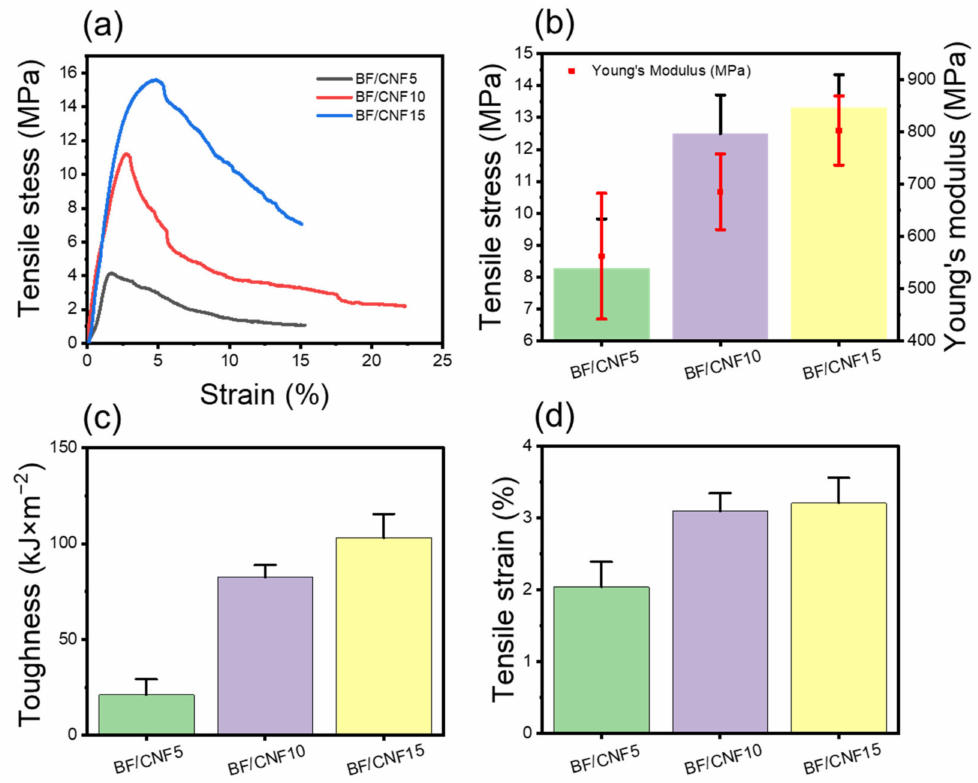
Figure 7. Mechanical properties of BF/CNF fibrous preforms. ( a ) Representative tensile stress–strain curve, ( b ) tensile stress and Young’s modulus, ( c ) toughness, and ( d ) tensile